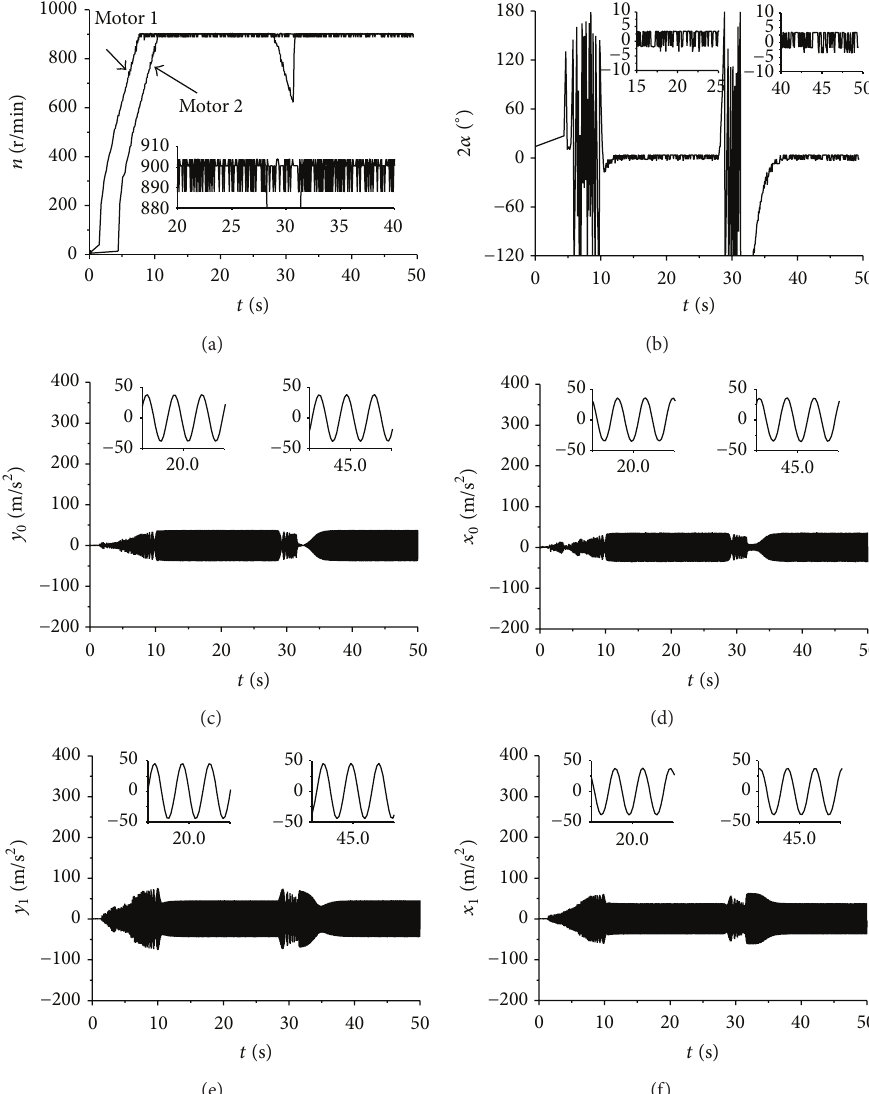
Figure 10: Experiment results with 𝑟 𝜓 ≈ 1.1 , 𝜂 = 1 , and 𝑟 𝑚 ≈ 0.03 : (a) rotational velocities; (b) the phase difference; (c) response in 𝑦 -direction for number 5; (d) response in 𝑥 -direction for number 5; (e) response in 𝑦 -direction for number 6; (f) response in 𝑥 -direction for number